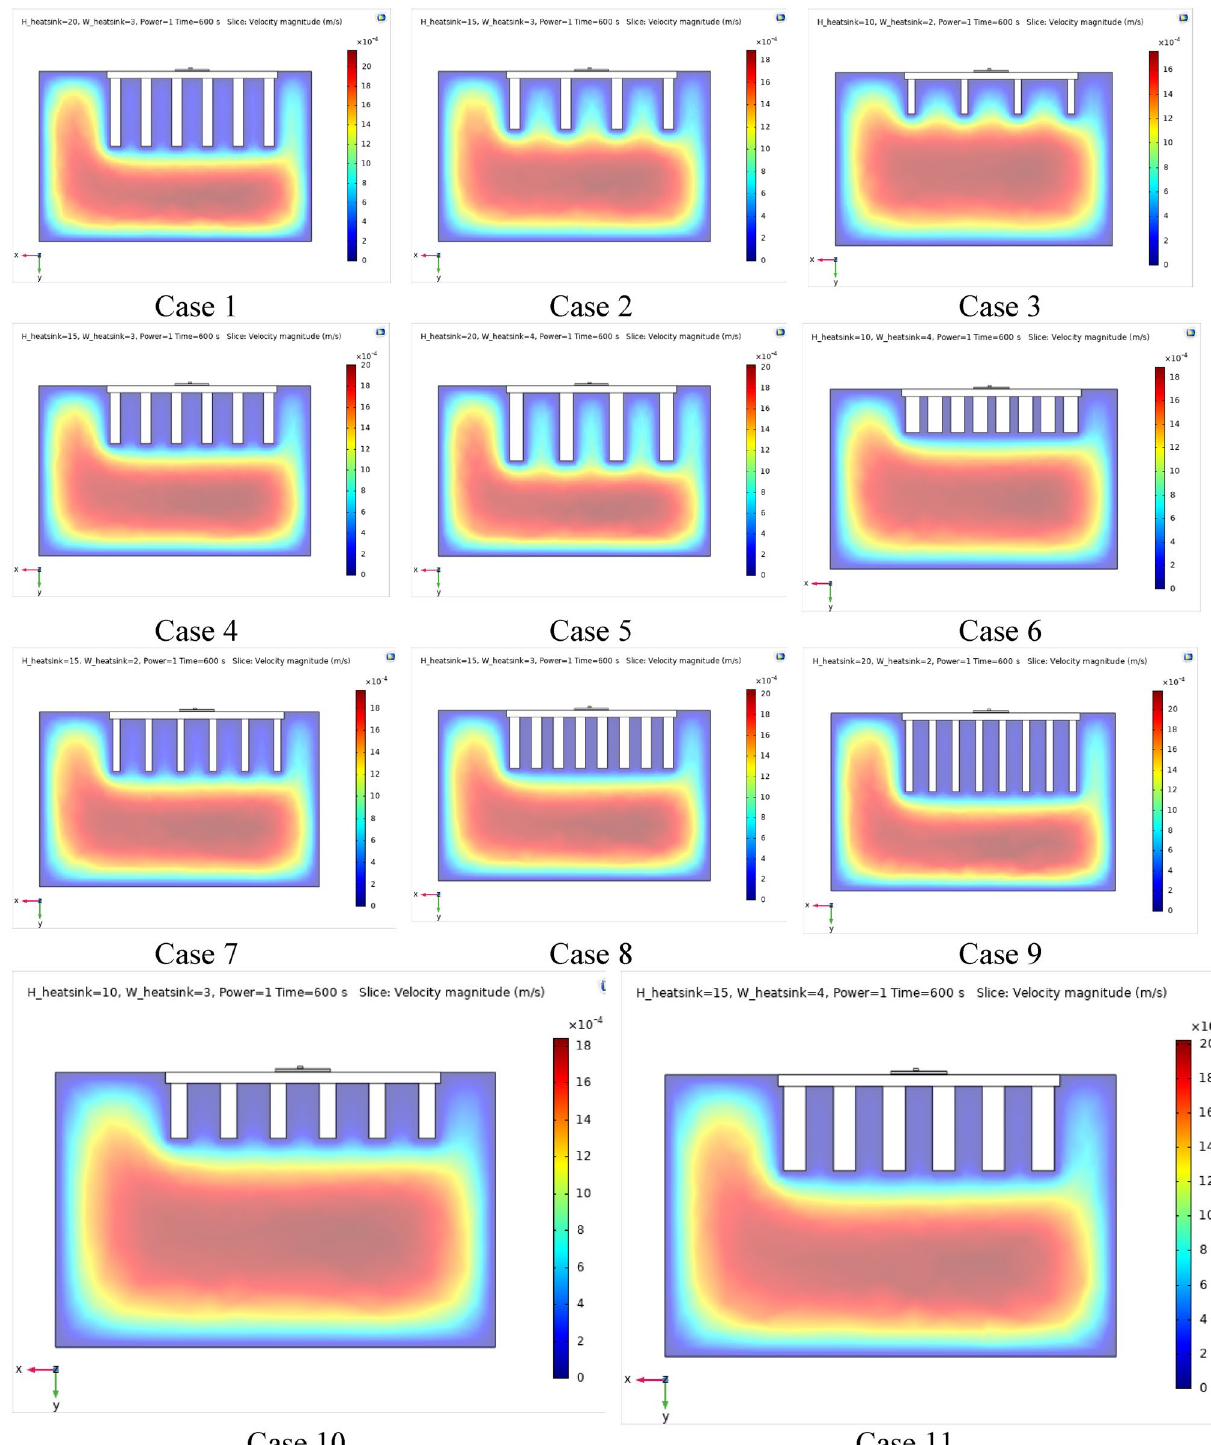
Figure 7. 2D Velocity contours for the finned micro-channel of different geometries (11 Cases) (COMSOL Multiphysics 5.6, https:// www. comsol.